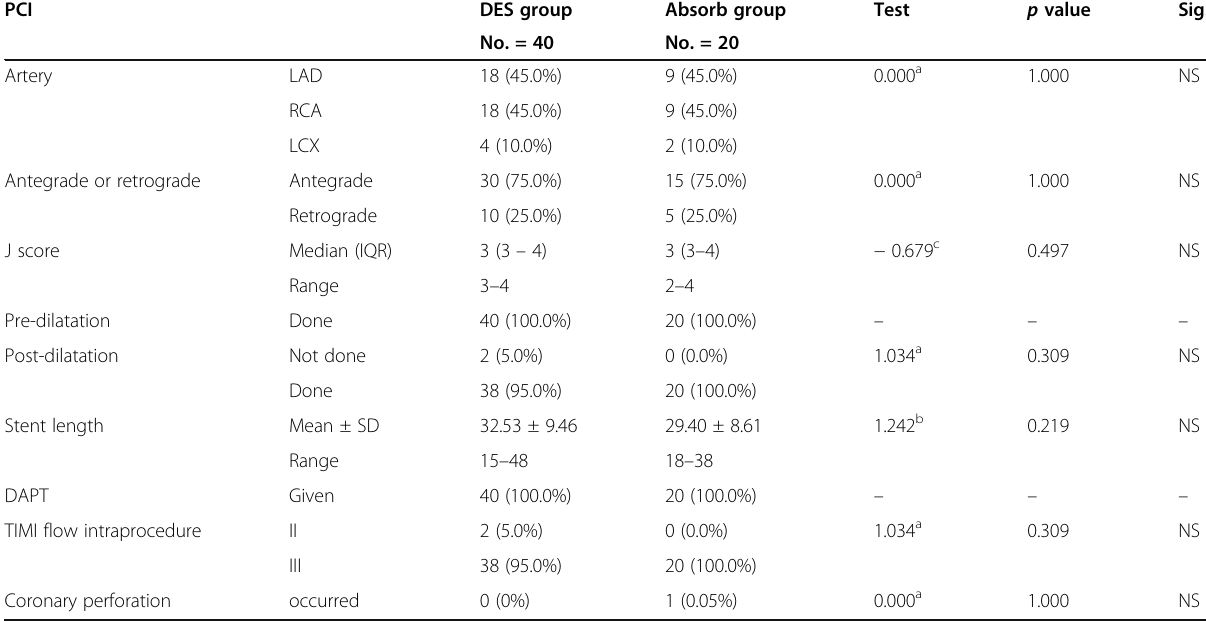
Table 4 Intraprocedural and post-procedural aspect during intervention